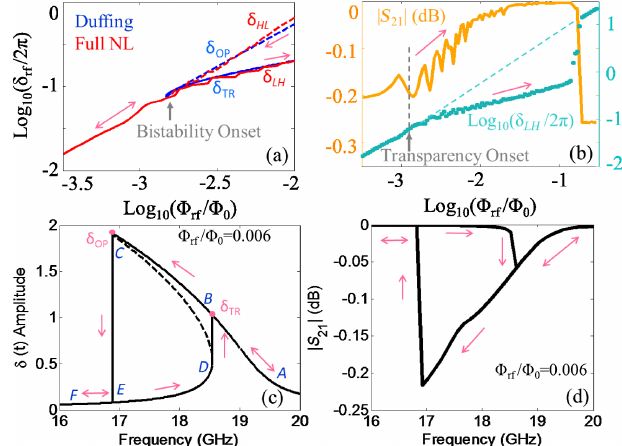
FIG. 3. Simulation results for a single rf SQUID in the bistable regime. The pink arrows denote the signal (frequency or rf flux amplitude) scanning directions. (a) The amplitude of gauge- invariant phase δ ð t Þ oscillation on resonance as a function of driving rf flux amplitude. Red curves denote the full nonlinear numerical results. The δ is the amplitude of δ ð t Þ when the LH frequency or rf flux scans from low value to high value, and δ is HL the amplitude for a reverse scan. Blue curves are calculated analytically with the Duffing oscillator approximation. The δ OP and δ denote the analytic amplitudes for the opaque state and TR the transparent state, respectively. The gray arrow points out the onset of bistability. (b) The simulated transmission (orange curve, left y axis) and the amplitude of δ ð t Þ (green curve, right y axis) on resonance as a function of rf flux for the transparent case during an upward-rf-flux scan. The dashed green line shows the δ ð t Þ amplitude interpolated between the low-power and high-power limits. The gray arrow shows the onset rf flux for transparency. It is the same as the bistability onset. (c) The foldover resonance of the amplitude of δ ð t Þ calculated in the Duffing oscillator approximation results in a bistable oscillation on resonance with amplitudes δ and δ , respectively, at an rf flux of 0 . 006 Φ 0 . TR OP The dashed curve plots the unstable solutions in the foldover resonance. (d) The numerically calculated transmission as a function of rf driving frequency at an rf flux of 0 . 006 Φ 0 shows that the frequency range of bistability is the same as analytically predicted in Duffing oscillator approximation in